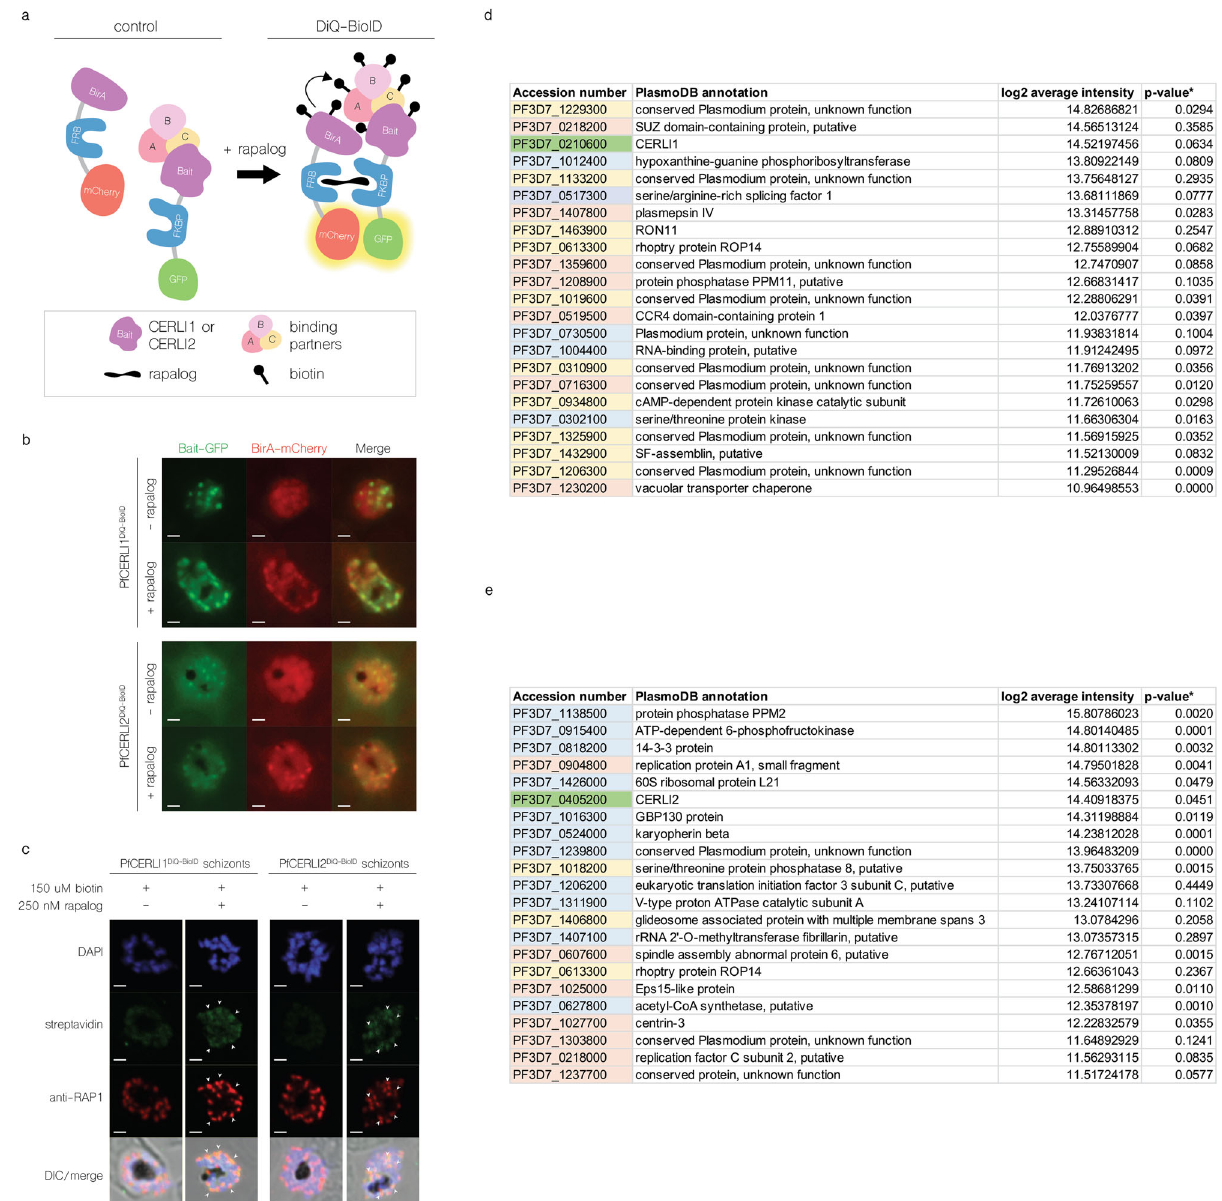
Fig. 8 DiQ-BioID of PfCERLI1 and PfCERLI2 reveals their protein interactome. a A schematic of the DiQ-BioID system under control and test conditions. b Pfcerli1 DiQ-BioID and Pfcerli2 DiQBioID parasites were treated for 8 h on rapalog to permit for dimerisation between the GFP-tagged bait construct and mCherry-tagged BirA, visualised by live fl uorescence. Scale bars = 2 μ m. c Biotinylation at the rhoptry bulb was con fi rmed by co-localising foci between RAP1 staining and a streptavidin-conjugated AlexaFluor488 in fi xed cells by IFA. Scale bars = 2 μ m. d Protein interactors for PfCERLI1. N = 3 biological replicates. e Protein interactors for PfCERLI2. N = 3 biological replicates. d , e Colour code corresponds to: green (bait protein), yellow (peak schizont- expressed), pink (late trophozoite to schizont stage-expressed), blue (uniformly or ring stage-expressed). * P -value calculated by t -test between intensity values in double-treated parasites and no rapalog controls. Proteins not identi fi ed in the no rapalog control were assigned with an intensity value of 0.